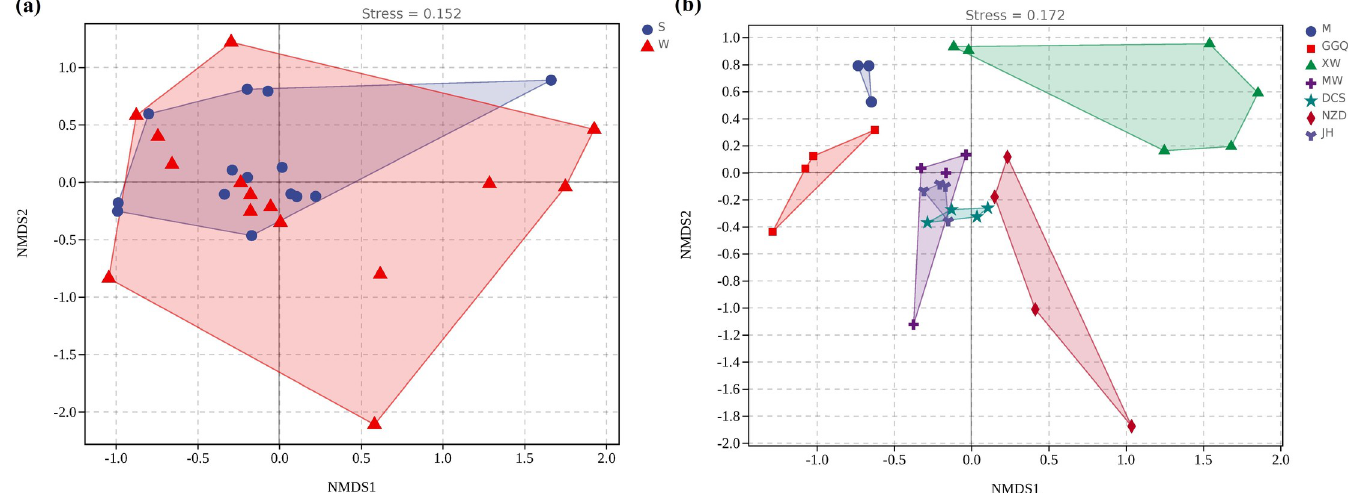
Fig 6. Archaeal community compositions of sediment samples as indicated by NMDS in different seasons (a) and reservoirs (b).